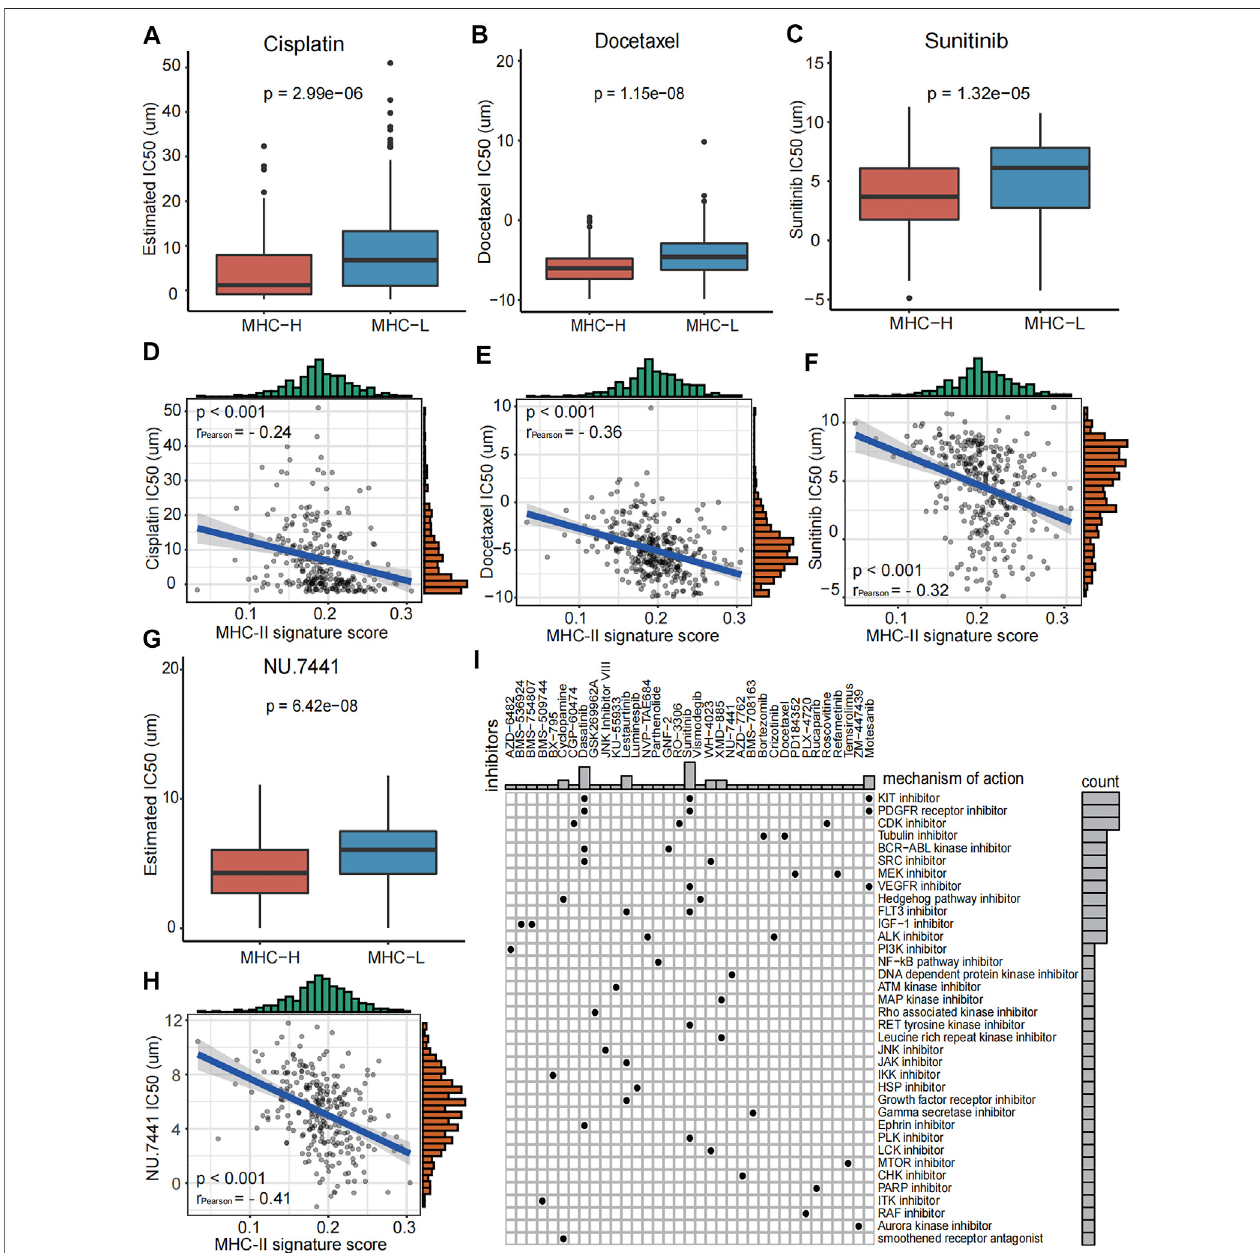
FIGURE 7 | Role of MHC-II signature in drug sensitivity prediction in the ICI-cohort. (A – H) Boxplots show that the IC50 values of Cisplatin (A) , Docetaxel (B) , Sunitinib (C) and NU.7441 (G) were signi fi cantly lower in the MHC-H group compared to the MHC-L group (Wilcoxon.test, P = 2.99e − 06, P = 1.15e − 08, P = 1.32e − 5, P = 6.42e − 08, respectively). And IC50 values of Cisplatin (D) , Docetaxel (E) , Sunitinib (F) and NU.7441 (H) were negatively correlated with MHC-II signature score (Pearson test, r Pearson = − 0.24, r Pearson = − 0.36, r Pearson = − 0.32, r Pearson = − 0.41, respectively. All P < 0.001. (I) Heatmap shows the MoA (row) shared by each compound (column, n = 35) in the ICI-cohort. The MoA is sorted according to the number of compounds sharing the MoA, displayed in the heatmap.